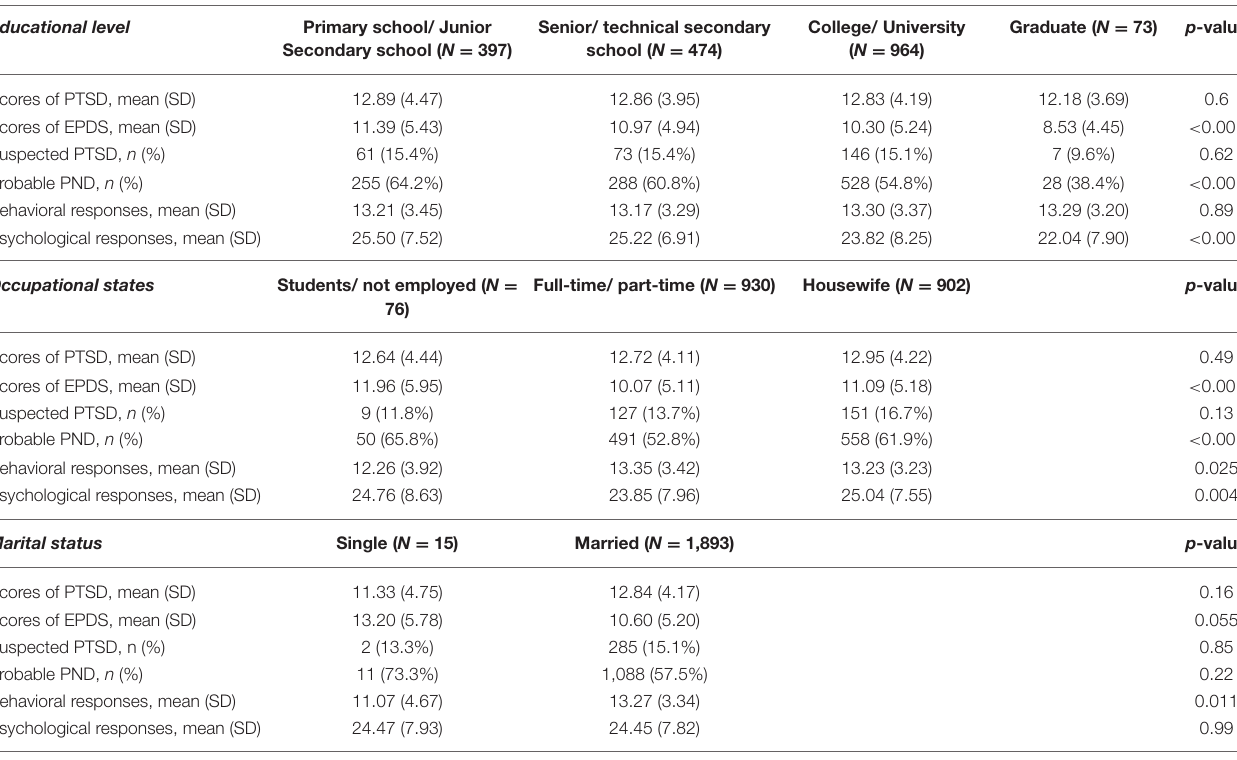
TABLE 2 | Demographic factors associated with the scores of scales.